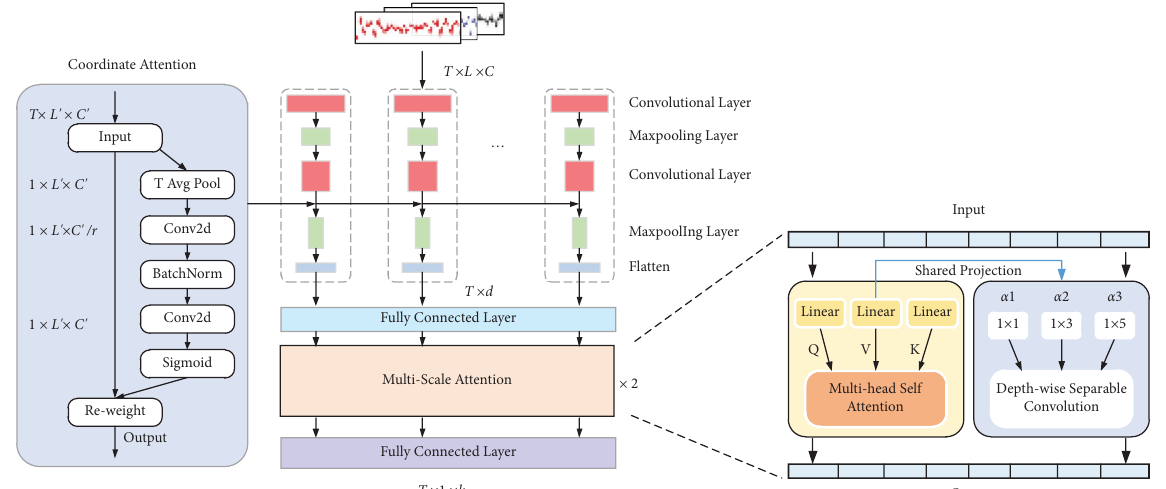
Figure 2: Te CA-CNN-MUSE